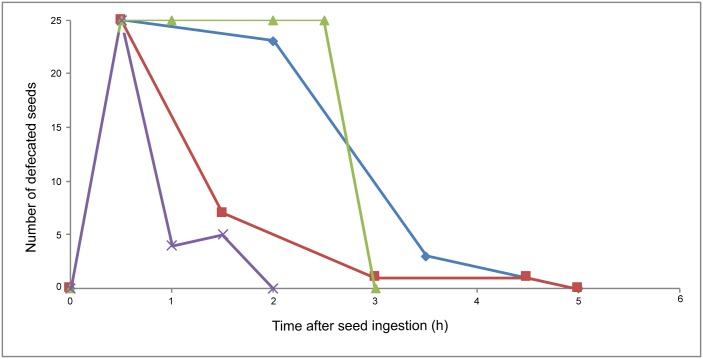
Gut retention times of Madagascan flying foxes.Seed retention time in four colour coded individual bats. The vertical axis represents number of fig seeds present in the faeces, the maximum of 25 refers to a score of ‘25 and over’. The horizontal axis represents time since the last feeding of a bat (seed ingestion). Measurements were made every 30 mins for up to 6 h after food was presented (after this time droppings were produced rarely). The bats produced 63 droppings in total.